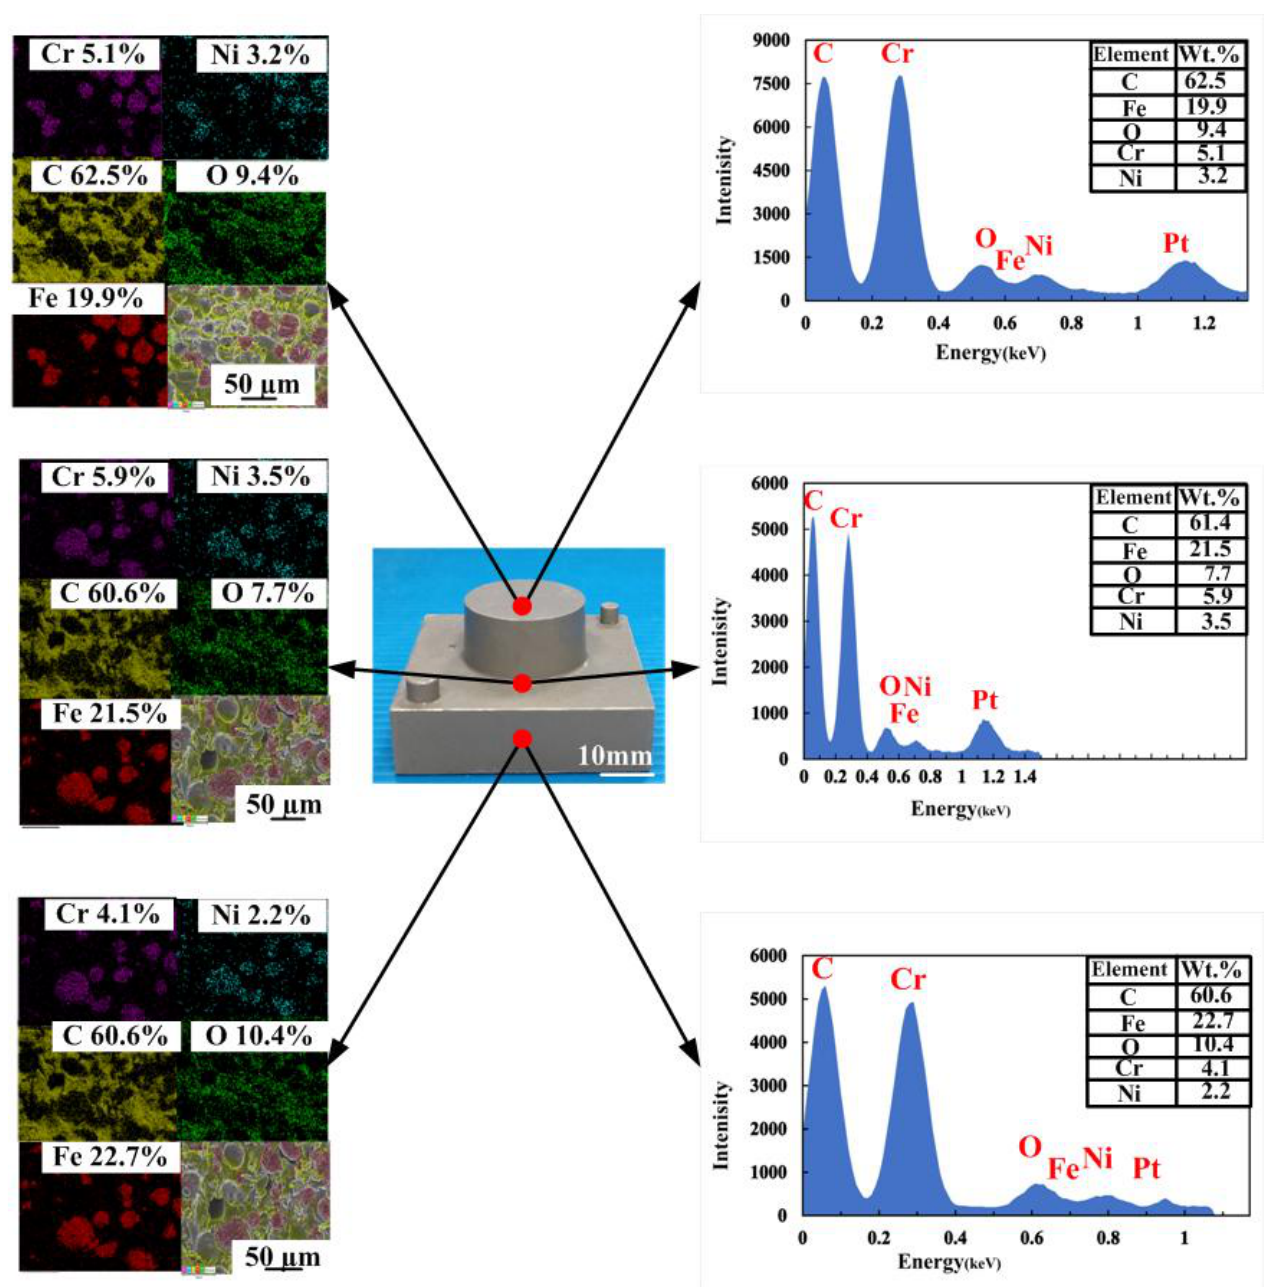
Figure 7. Precipitation analysis of the injection mold fabricated by epoxy resin filled with SUS 316 powder.